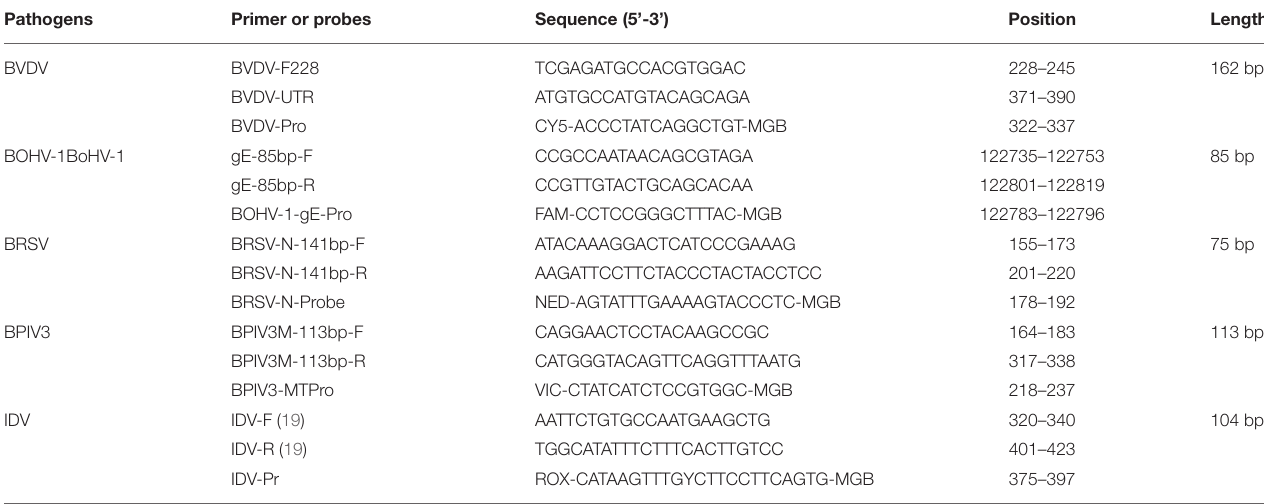
TABLE 1 | Primer and probes used in this